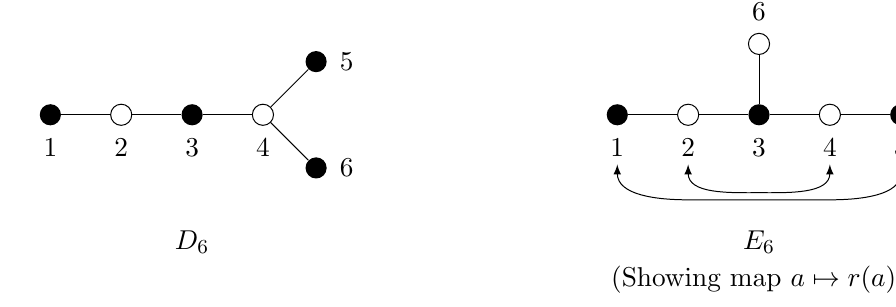
Figure 4 . The Dynkin diagrams of D 6 and E 6 showing the bi-colouration and the map r